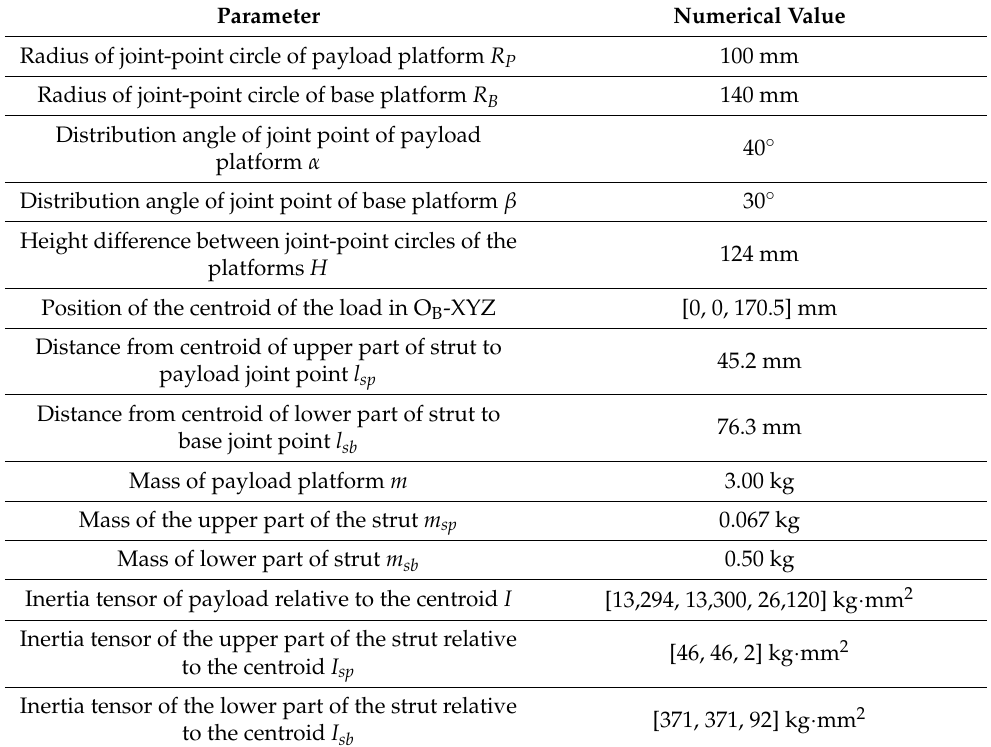
Table 1. Main parameters of the